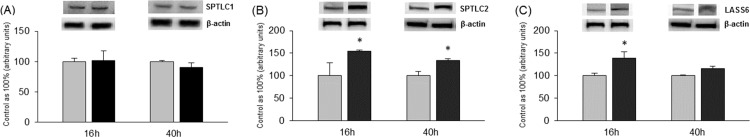
Expression of enzymes involved in hepatic sphingolipid metabolism i.e. SPTLC1 (A), SPTLC2 (B) and LASS6 (C) in primary rat hepatocytes.Cells were incubated in high glucose DMEM culture medium without (Control group) or with palmitate (0.75 mM) (Palmitate group) for 16h and 40h. Thereafter primary hepatocytes from each experimental group were prepared as it was described previously in Materials and Methods. Protein concentration was measured by BCA method. Expression of LASS6, SPTLC1 and SPTLC2 was analyzed by western blotting. The data are expressed as the mean ± SEM and are based on six independent determinations (n = 6). *P<0.05 significant difference: Control group vs. Palmitate group. Grey bars are referred as control groups and black bars are referred as palmitate groups.